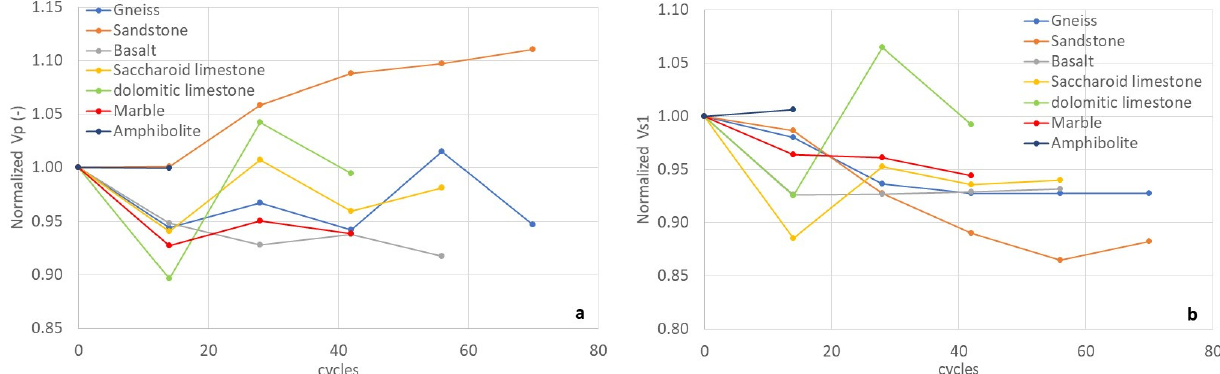
Figure 5. Evolution of the normalized mean P-waves ( a ) and S1-waves ( b ) of the samples—values are normalized by the initial mean.